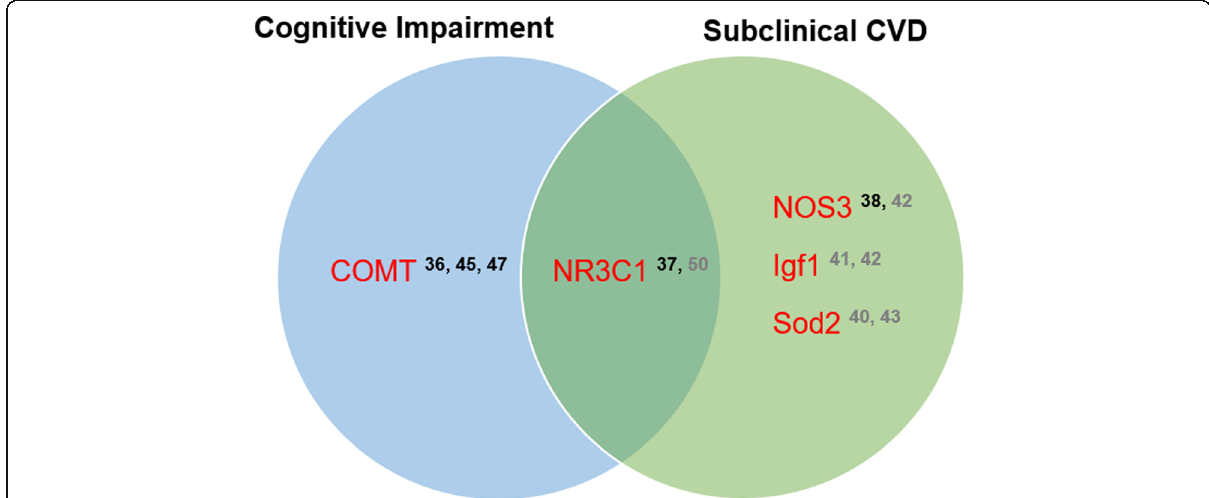
Fig. 2 Genes identified in more than one study in association with cognitive impairment and/or subclinical CVD. Grey numbers = animal studies; black numbers = human studies; CVD = cardiovascular disease; COMT = catechol-O-methyltransferase; Igfl1 = insulin-like growth factor like family member 1; NOS3 = nitric oxide synthase 3; NR3C1= nuclear receptor subfamily 3 group C member 1; Sod2 = superoxide dismutase 2.